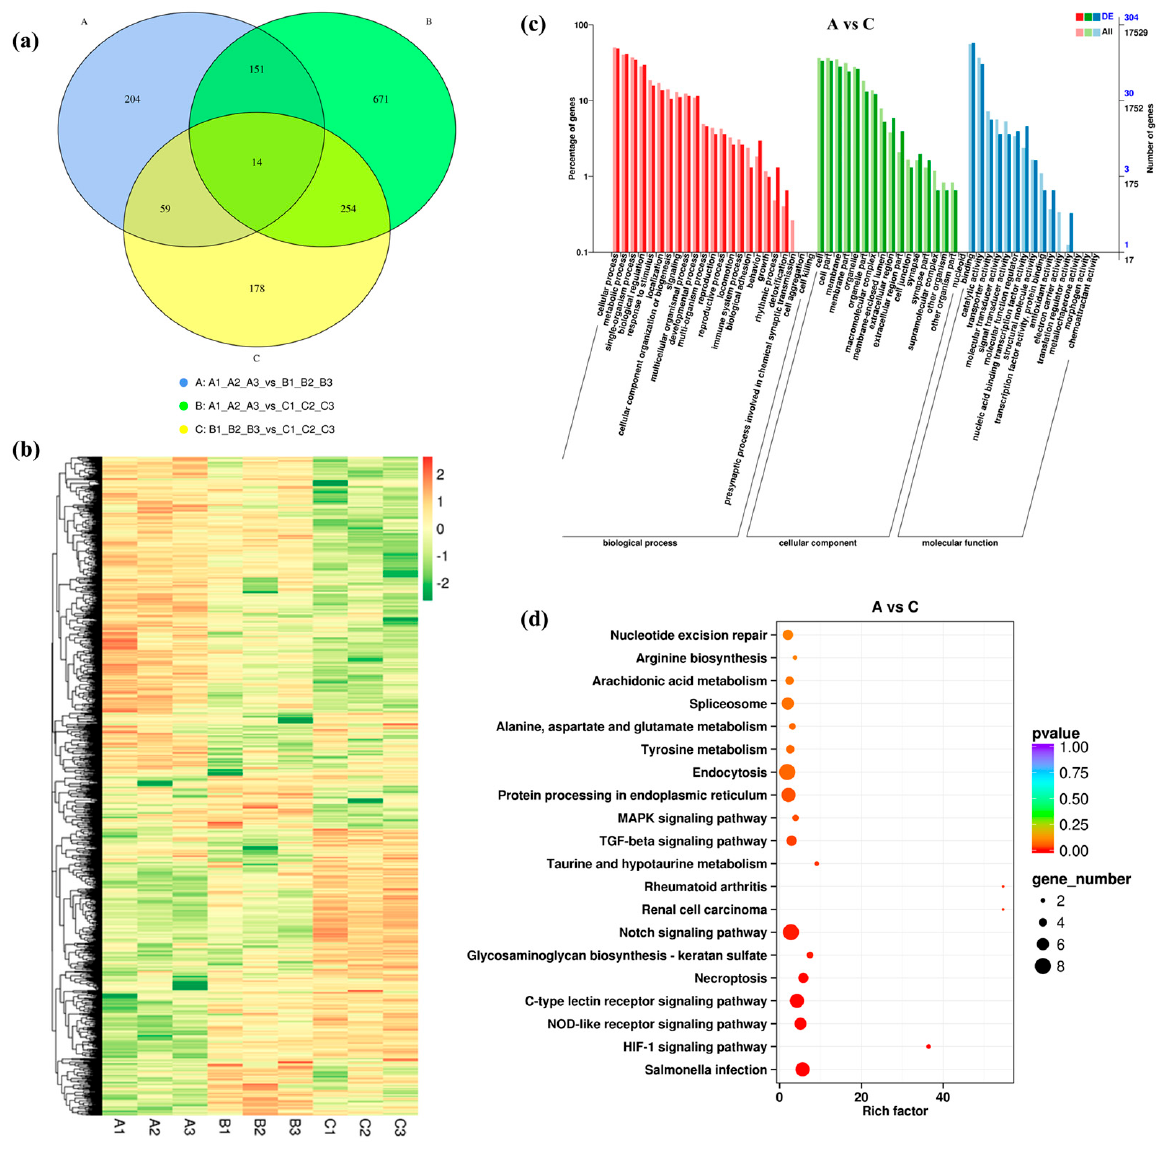
Figure 1. Identification and analysis of DEGs under salinity stress. ( a ) Venn diagram showing the number of DEGs in groups A vs. B, A vs. C and B vs. C. ( b ) Heat map of all DEGs. ( c ) GO enrichment analysis of DEGs in groups A vs. C. ( d ) KEGG enrichment analysis of DEGs in groups A vs. C.